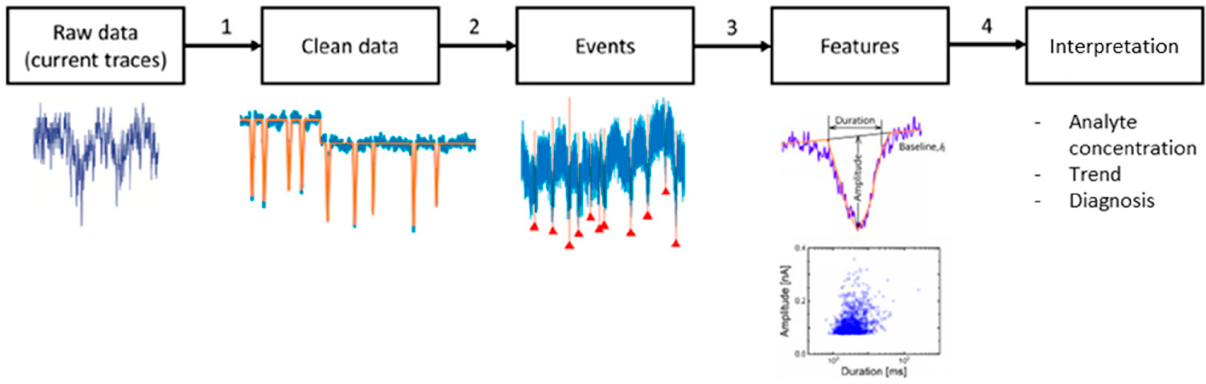
Figure 12. Four steps for signal processing: ( 1 ) noise filtering; ( 2 ) signal identification; ( 3 ) signal characterization; ( 4 ) signal interpretation. Adapted with permission from Ref. [153], Copyright 2019.